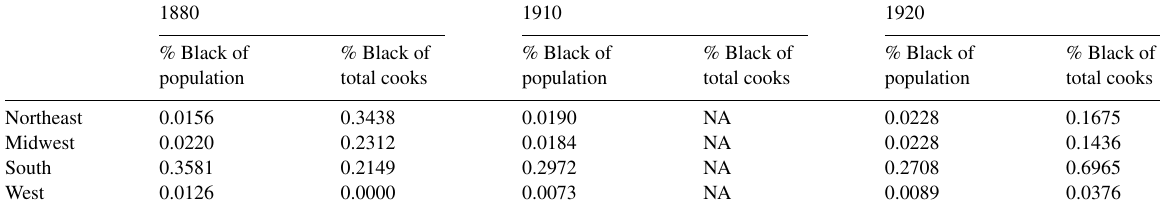
Table 4 U.S. Black cook (caterer) employment